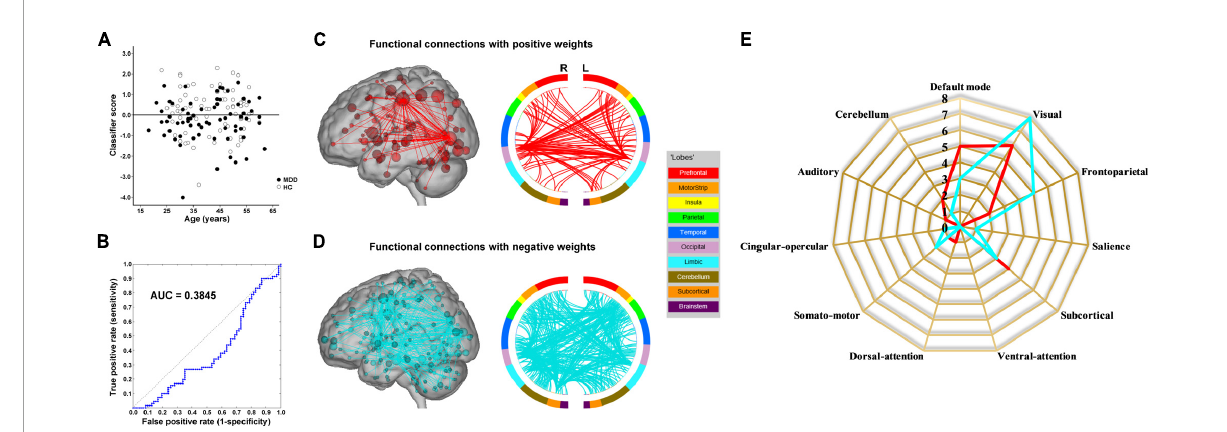
FIGURE3 Static functional connectivity-based classification. (A) Scatter plot showing classification scores of all the subjects. (B) Receiver operating characteristic (ROC) curve of the classifier. (C) High-degree nodes (degree ≥ 50, larger spheres indicate nodes with higher degree) and their connections in the positive network. (D) High-degree nodes (degree ≥ 50) and their connections in the negative network. (E) Fingerprints of the 25 highest-degree nodes summarized by overlap with canonical neural networks.